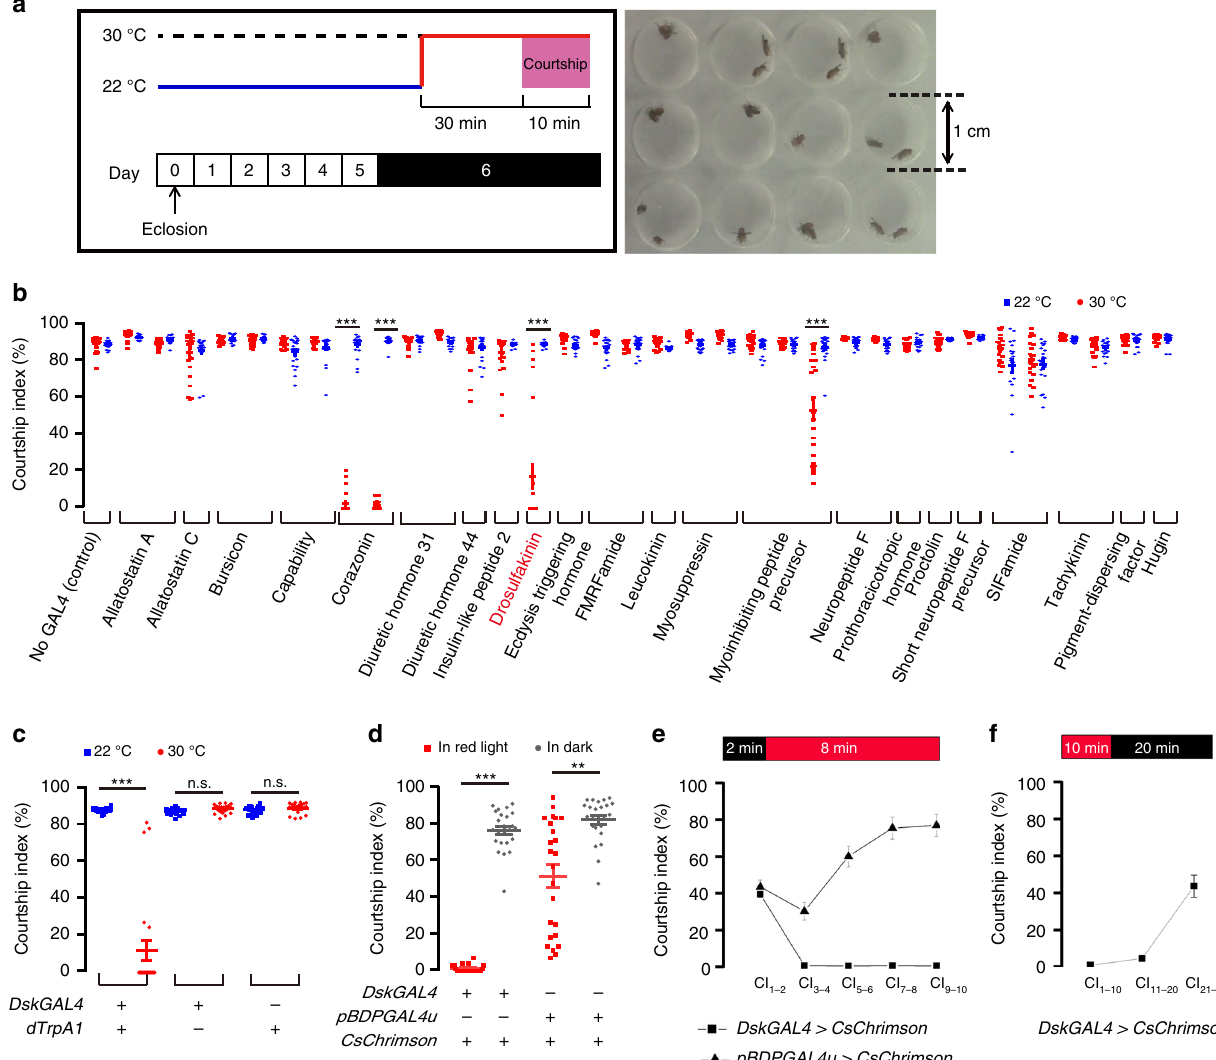
Fig. 1 Identi fi cation of DskGAL4 neurons that inhibit male courtship. a Experimental design of screening for courtship-inhibiting neurons. b Identi fi cation of DskGAL4 and CrzGAL4 that inhibit male courtship when driving UAS-dTrpA1 at 30 °C (red circle) compared to permissive temperature 22 °C (blue square). n = 12 for sNPF-GAL4 and Lk-GAL4, n = 18 for Burs-GAL4, Dh31-GAL4 and Proc-GAL4, n = 20 for SIFaGAL4s , n = 24 for others. *** p < 0.001, Mann – Whitney U test. c Thermogenetic activation of Dsk neurons labeled by another DskGAL4 (attP2) severely inhibits male courtship. n = 24 for each. p < 0.001, Kruskal – Wallis test. *** p < 0.001 and p > 0.1 (n.s.), post hoc Dunn ’ s multiple comparisons test. d Optogenetic activation of DskGAL4 (attP2) neurons abolishes male courtship. n = 24 for each. p < 0.001, Kruskal – Wallis test. ** p < 0.01 and *** p < 0.001, post hoc Dunn ’ s multiple com p arisons test. e Optogenetic activation of DskGAL4 neurons rapidly inhibits male courtship. n = 24 for each. f Courtship inhibition by optogenetic activation of DskGAL4 n eurons lasts for more than 10 min after lights off. n = 24. n.s. not signi fi cant. Error bars indicate SEM. Source data are provided as a Source Data fi and anti-DSK between males and females (Supplementary Fig. 5a), indicating that these Dsk neurons are not sex-speci fi c. Thus, we also activated DskGAL4 neurons using dTrpA1 (Supplementary Fig. 5b) or CsChrimson (Supplementary Fig. 5c) body raised against DSK (antigen: FDDYGHMRF, recognized in females and observed signi fi cantly reduced receptivity two DSK peptides, DSK-1 and DSK-2), which faithfully labels to courting wild-type males. These results indicate that Dsk - MP1 and MP3 cells, and a number of interneurons in both the expressing neurons are common in both sexes and suppress male brain and the ventral nerve cord (Fig. 2a), consistent with pre- and female sexual behaviors, and we focused on male courtship in vious fi ndings 39 . It should be mentioned that our DskGAL4 did not label neurons in the VNC. It is possible that those antibody- this study (but see below for their interaction with sex-speci fi c labeled neurons in the VNC are not Dsk -expressing neurons, but neurons in both males and females). the DSK antibody cross-reacts with other peptides in those neurons (e.g. FMRFamide-related peptides). Alternatively, those neurons in the VNC are indeed Dsk -positive, but the DskGAL4 only labels a part of Dsk -expressing neurons. We observed no and DskGAL4 neurons ( LexAop-RedStinger/UAS-stinger-GFP; gross anatomy difference of Dsk neurons using both anti-GFP